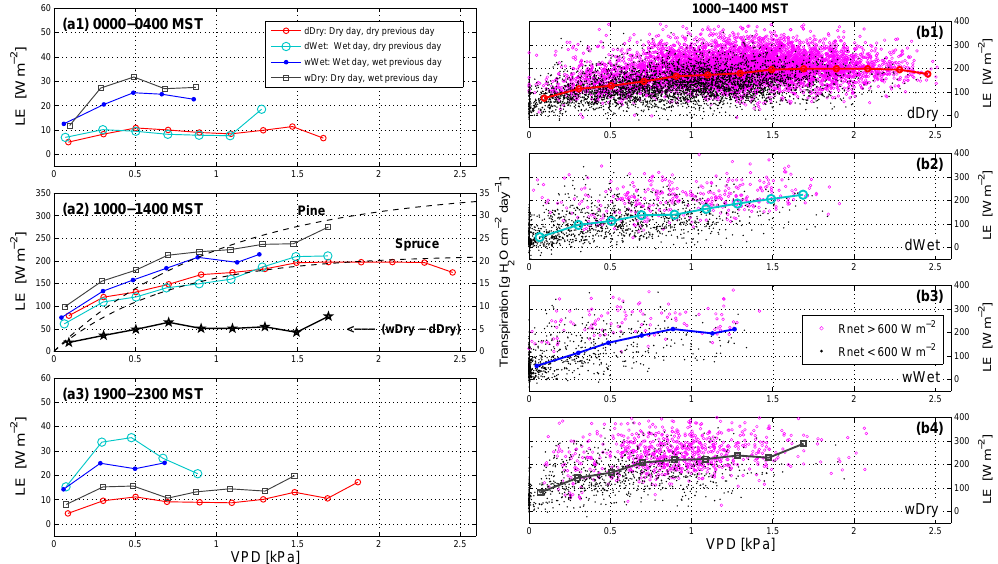
Figure 11. The (left column) binned 21.5m latent heat flux LE vs. 21.5m vapor pressure deficit VPD for (a1) night (00:00–04:00MST), (a2) daytime (10:00–14:00MST), and (a3) evening (19:00–23:00MST) periods. Each line represents a different precipitation state as shown in the legend. In (a2) , the dashed black lines are the empirical exponential fits of transpiration per unit sapwood area vs. VPD for 2006 as determined by Hu et al. (2010b) for pine and spruce trees (using the right-hand axis). Also, the difference in LE between wDry and dDry conditions is shown as a solid black line. As an example of the variability in the binned data, the right-column panels show the 30min daytime data used to create the binned daytime lines (i.e., corresponding to what is shown in panel a2 ). The right-column panels are for (b1) dDry, (b2) dWet, (b3) wWet, and (b4) wDry periods. In the scatter plots, the individual points are distinguished by R net as shown by the legend in (b3)